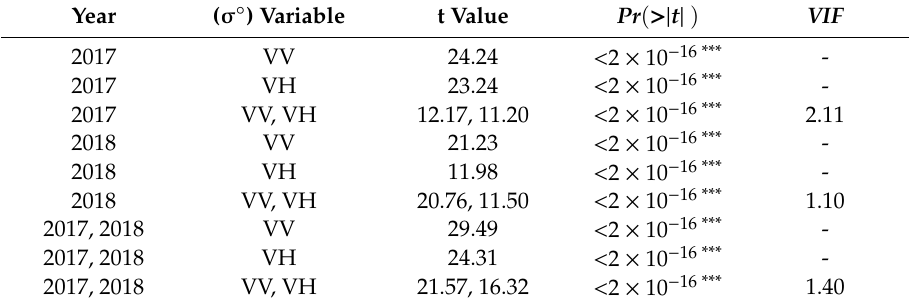
Table 7. Analysis of variance in the generalized model.